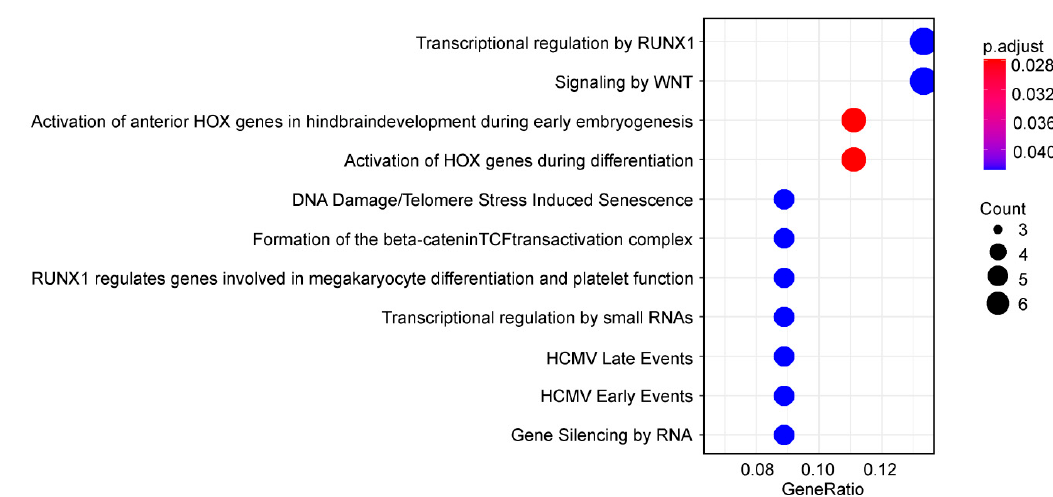
Figure 5. Dotplot enrichment map showing cellular pathways associated with down-regulated GDTEs from HEK293 cells knocked down of eL38. Designations are the same as in Figure 4.